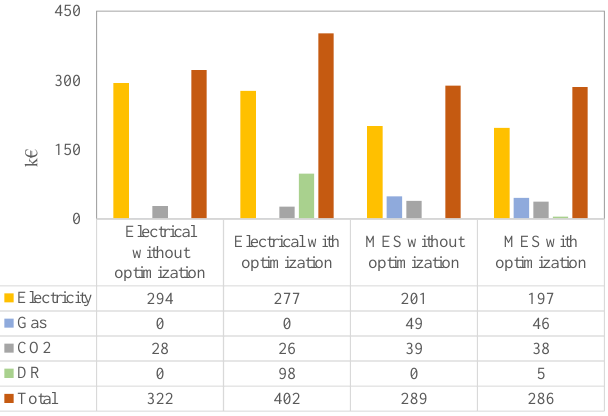
Figure 23. Annual costs of electricity, gas, CO 2 emissions and DR